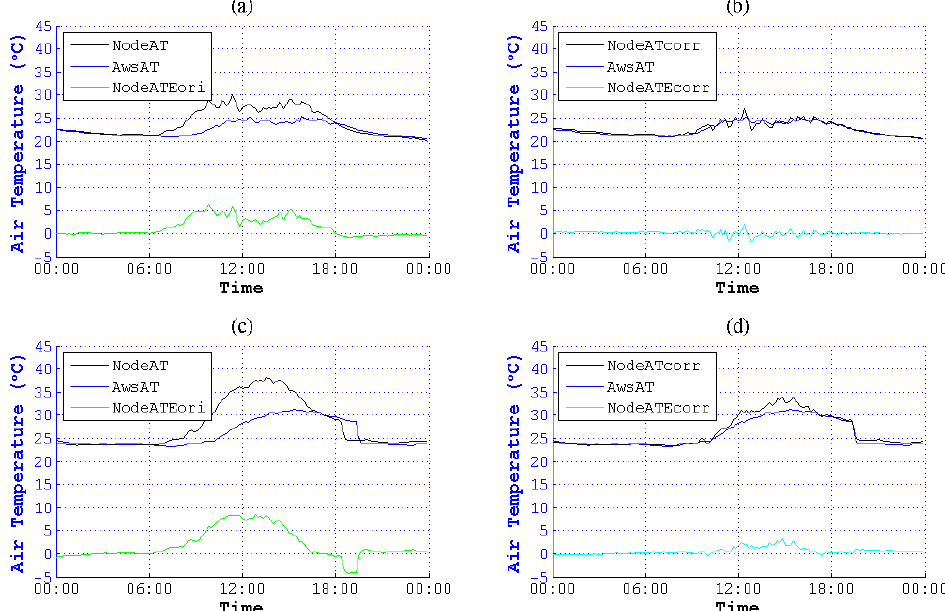
Figure 14. Contrast of NodeAT and NodeATcorr on 3 September 2014 and 28 September 2014. ( a ) Original data on 3 September 2014; ( b ) corrected data on 3 September 2014; ( c ) original data on 28 September 2014; ( d ) corrected data on 28 September